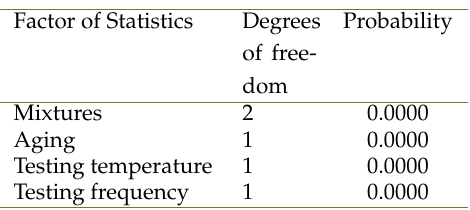
Table 4. ANOVA results for dynamic modulus values Factor of Statistics